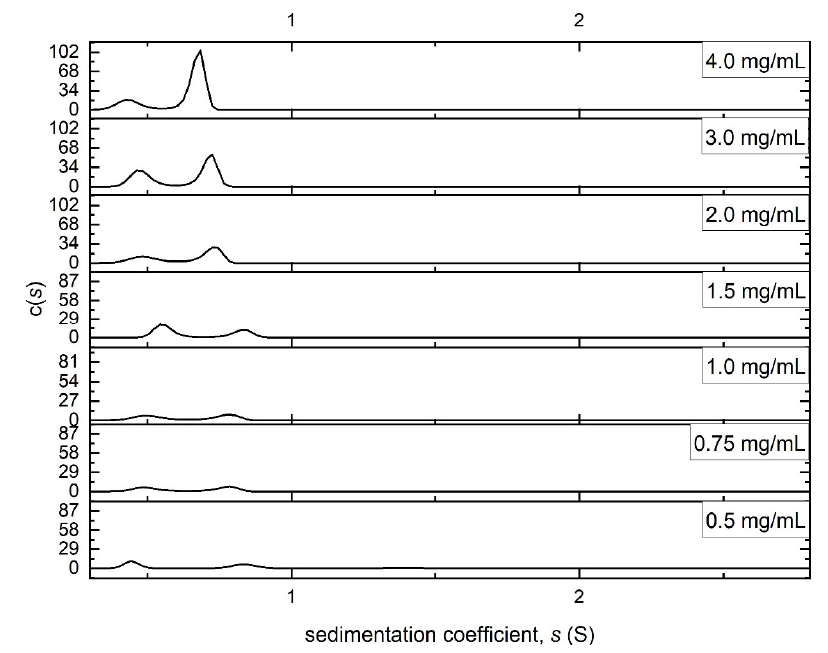
Figure 3. Sedimentation coefficient distributions of Butvar B-98 at different loading concentrations in isopropanol. Rotor speed = 49,000 rpm, temperature = 20.0 °C.